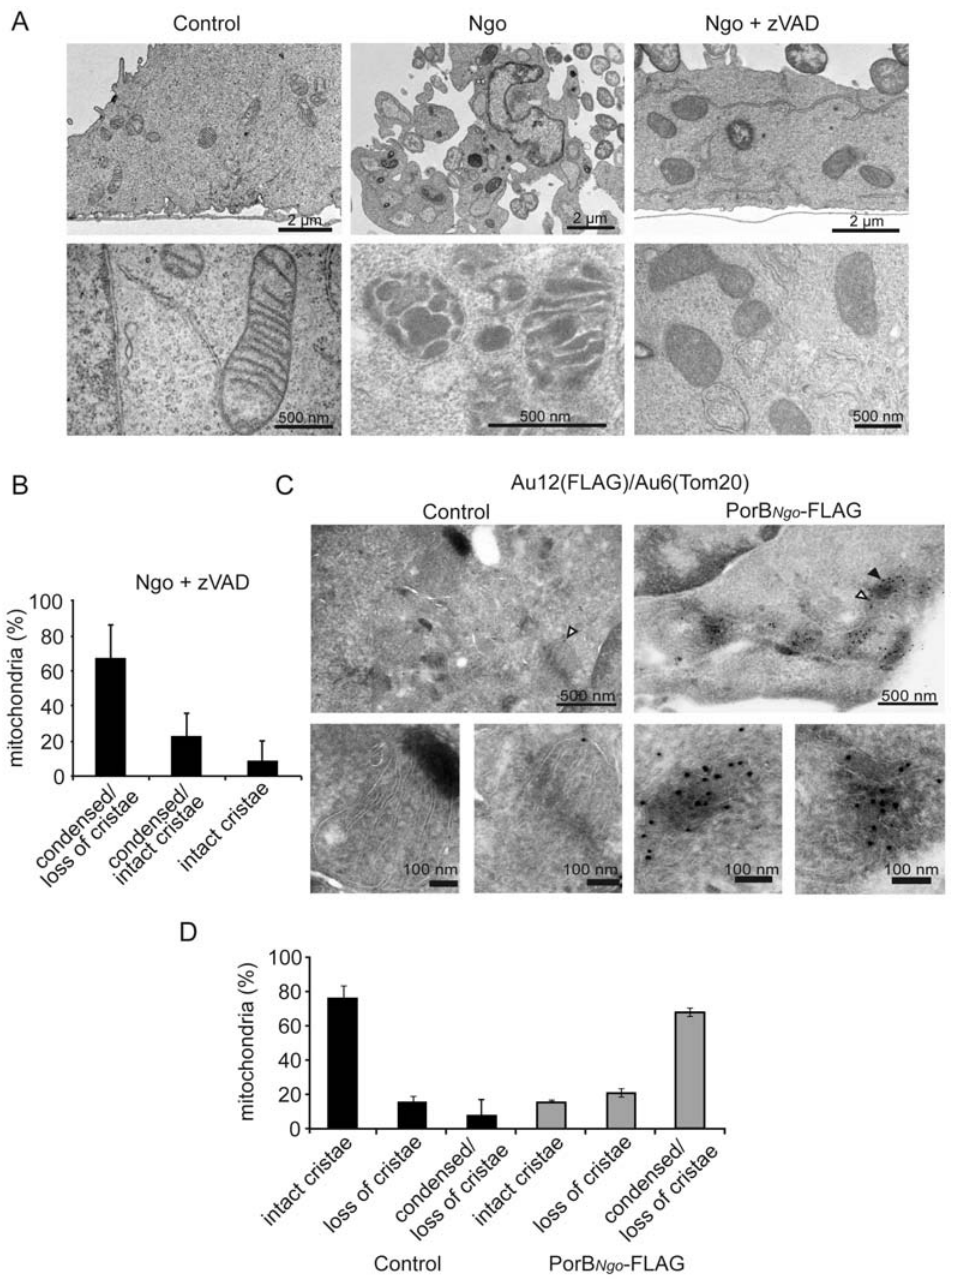
Figure 2. PorB-induced rearrangement of the inner mitochondrial membrane. ( A ) HeLa cells infected in the presence or absence of zVAD were analyzed by EM to detect the structural changes in the mitochondria. Representative sections of control, infected (Ngo) and infected, zVAD treated cells (Ngo + zVAD) are shown (upper panel). The mitochondria were viewed at higher magnification to analyze alterations in the cristae architecture (lower panel). ( B ) A total of 500 mitochondria were counted from cells infected and pretreated with zVAD and analyzed for condensation and loss of cristae. The graph shows the relative number of mitochondria with the indicated phenotypes of all analyzed mitochondria. Data are mean 6 SD of three independent experiments. ( C ) Transfection of porB leads to loss of cristae and matrix condensation. FLAG-tagged PorB was detected by immunogold labeling with a primary FLAG antibody and a secondary antibody linked to 12 nm gold particles (filled arrow head). Endogenous protein of the OMM (Tom20) was co-stained with the respective antisera and a secondary antibody linked to 6 nm gold particles (open arrow head). ( D ) Normal mitochondria or mitochondria with condensed matrix and disrupted cristae were quantified in PorB-expressing and control cells and expressed as % of total mitochondria. Data are mean 6 SD of three different